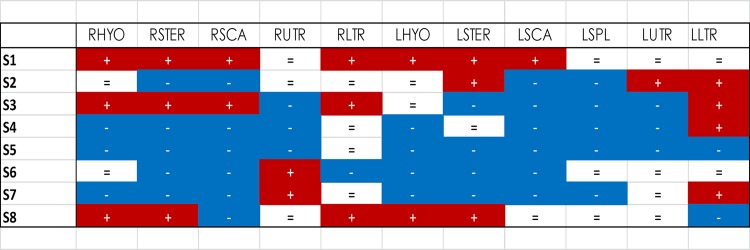
Individual variation of EMG amplitude change.Individual data for each of the eight subjects showing the direction of change in EMG amplitude of each muscle between the baseline and painful conditions. Red (+) indicates an increase of EMG amplitude in the painful condition compared to baseline, blue (-) indicates decreased EMG amplitude and white (=) indicates no change. Note the individual specific patterns of modulation of EMG amplitude. No two subjects showed the same strategy. The threshold was set to ±10% of the baseline average EMG amplitude value. (Right–R and Left–L: Sterno Hyoideus–HYO, Sternocleidomastoideus-STER, Anterior Scalenus-SCA, Splenius Capitis–SPL, Upper trapezius-UTR, Lower Trapezius-LTR).